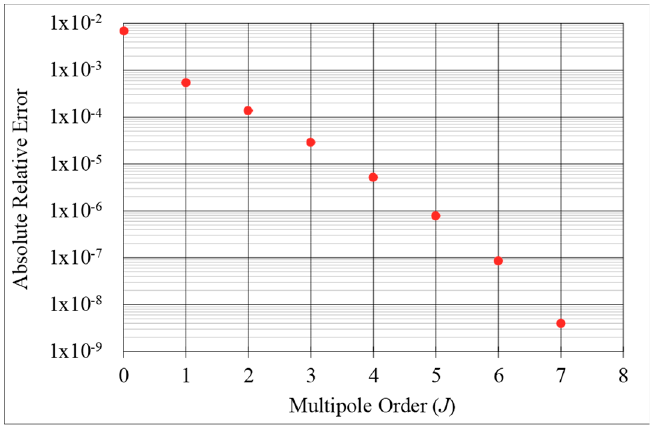
Figure 7. Absolute relative error ∆ R b for J = 0, 1, 2, …7 for the reference case (39).